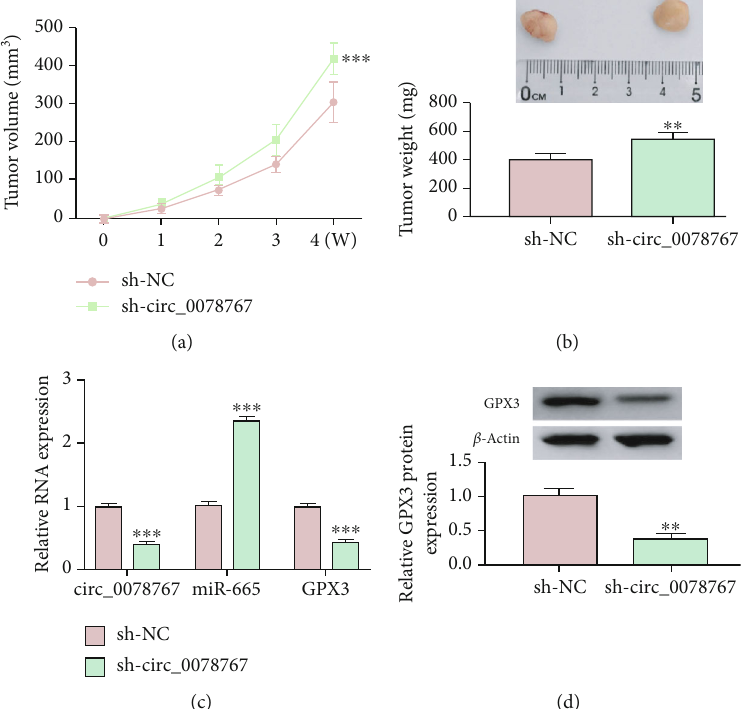
Figure 8: Circ_0078767 knockdown promoted tumor growth in vivo. (a, b) Tumor volume and weight after circ_0078767 knockdown in vivo. (c) Relative expression levels of circ_0078767, miR-665, and GPX3 in xenografts were detected by qRT-PCR. (d) GPX3 protein level tested by western blot in xenografts. ∗∗∗ P < 0 : 001